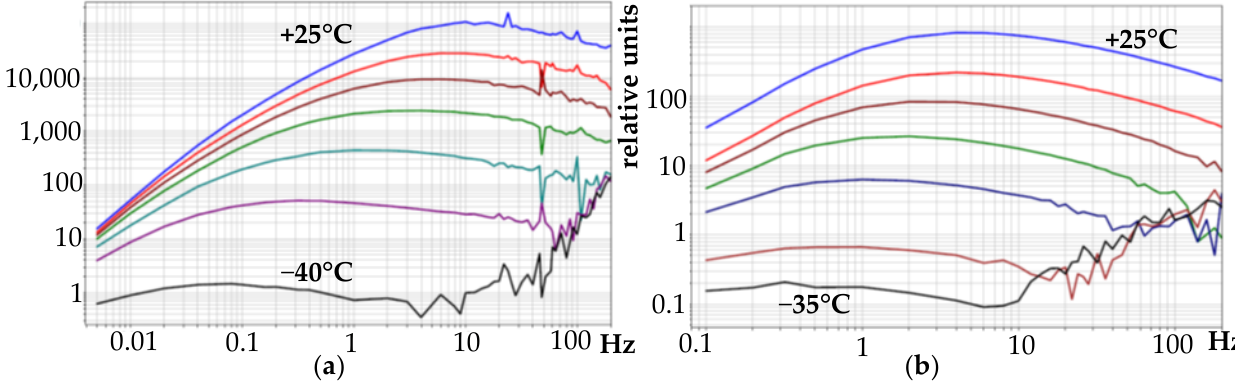
Water/LiI/PC, J 2 = 0.01 mol/liter; (b) For the electrolyte sample #6: Water/KI/PC, J 2 = 0.05 mol/liter.